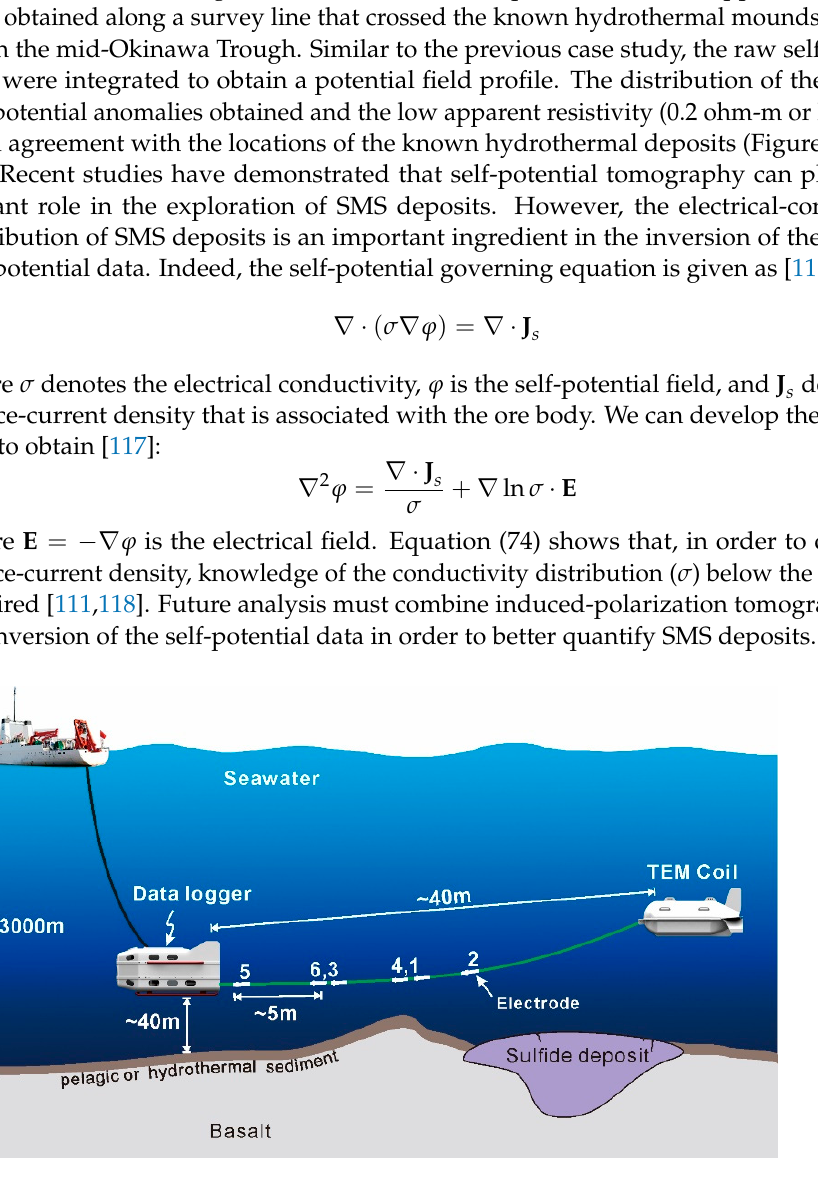
Figure 36. Self ‐ potential tomography of self ‐ potential data. The tomography is performed in terms of the causative source ‐ current ‐ density distribution below the seafloor. ( a ) Inverted source ‐ current ‐ model distribution. The black dots denote the positions of the electrodes in the seawater. ( b ) Cross ‐ sections along east–west with y = 0 m and y = 70 m. ( c ) Tomography of the in ‐ verted source ‐ current ‐ density distribution below Profiles SP01 and SP02. ( d ) Inferred ore body shape from the inverted data (domain where the magnitude of current density is lower than − 0.5 mA m − 2 ). Note that the lateral extension of the ore body is limited by the self ‐ potential dataset that is acquired only along two parallel lines (modified from [115]).